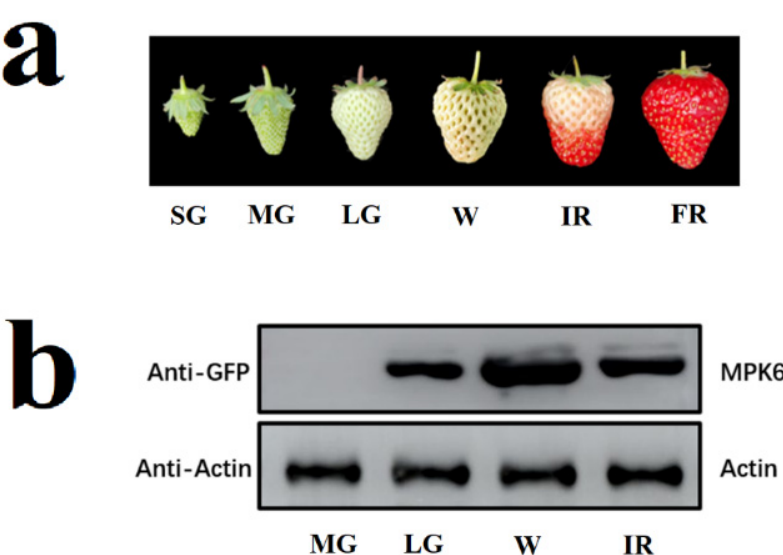
Figure 1. Accumulation of FaMPK6 following over-expression at different fruit developmental stages. ( a ) fruit phenotypes at different developmental stages. SG, small green; MG, middle green; LG, large green; W, white, IR, initially reddening, FR, fully reddening. ( b ) detached fruit at different developmental stages were transiently transformed with A. tumefaciens carrying a FaMPK6: eGFP fusion construct driven by the pSuper promoter. On day 4 after transformation, proteins were extracted from the fruit, and the amount of FaMPK6 was determined by immunoblotting with an anti-GFP antibody.